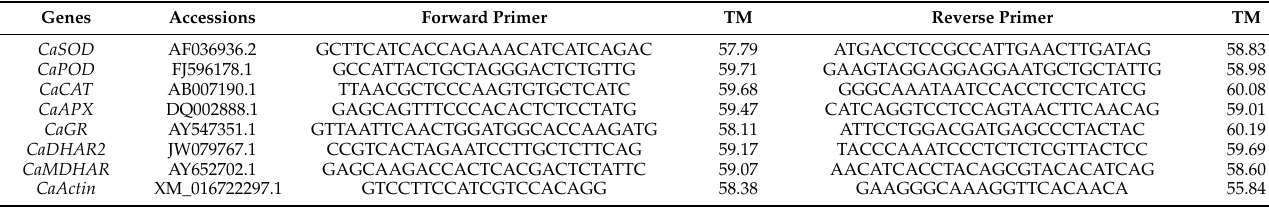
Table 1. Table 1. Primers used for the